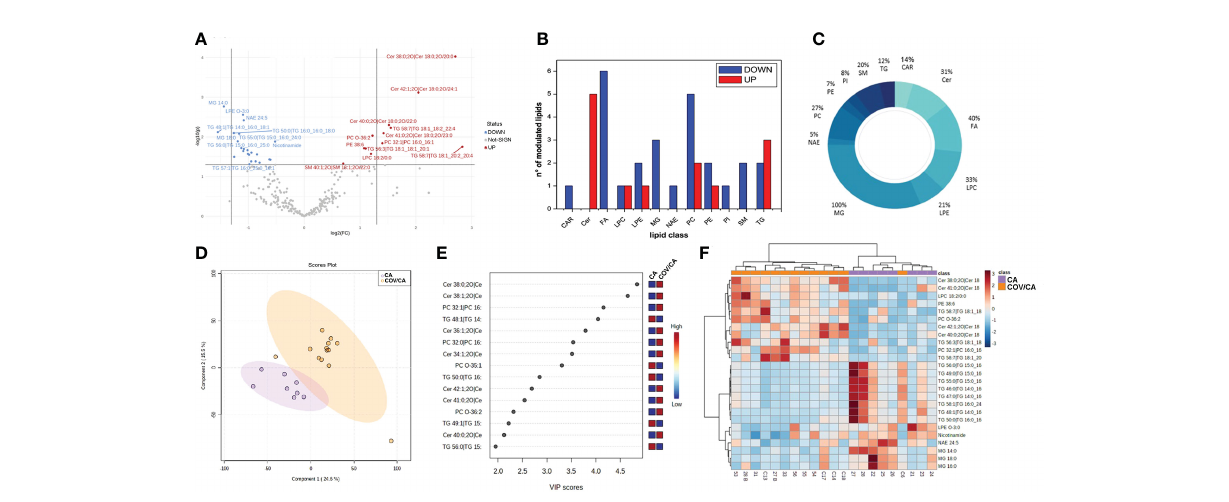
FIGURE 4 Alteration of lipids in PBMCs from COVID-19 cancer patients vs cancer-only patients. (A) Volcano plot depicting the modulation of 35 lipids (FC > 1.3 and p -value < 0.05), 23 under-expressed and 12 over-expressed; graphs showing (B) the number of upregulated (red) and downregulated (blue) lipid species within each single class of lipids and (C) the percentage of modulated lipid species for each lipid class. (D, E) Partial least square discriminant analysis (PLS-DA) of PBMC lipidomic pro fi les, showing (D) the presence of two separate groups of patients and (E) the most important discriminating variables for each group, colored boxes indicating the most predictive or discriminative features in each group, VIP scores (variable importance in the projection) (red: high; blue: low). (F) Hierarchical heat maps of the abundances of quanti fi ed lipids highlighting the two clusters of samples, with COV/CA in orange and CA in purple. CA ( n = 8) and COV/CA ( n = 13)